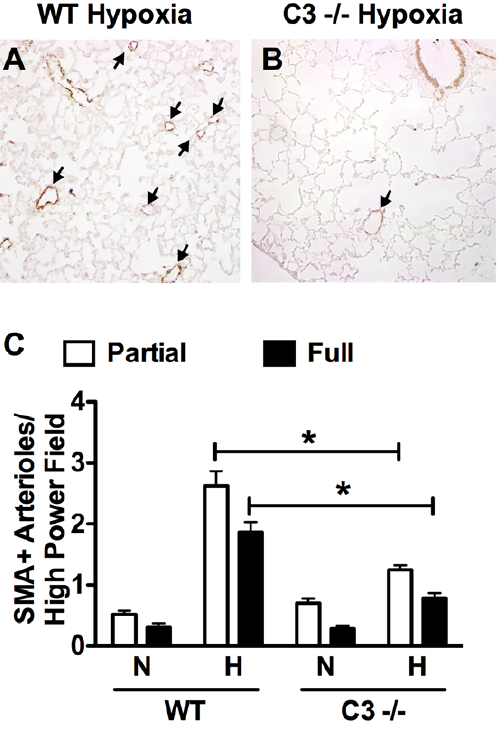
Figure 4. Loss of C3 attenuates muscularization of pulmonary arterioles in response to CH. (A–B) Representative photomicro- graphs of lungs stained against SMA from (A) hypoxic WT and (B) C3 2 / 2 mice. Arrows indicate muscularized arterioles. (C) Quantification of the number of partially and fully muscularized arterioles ( , 100 m m) per high power field (200 6 total magnification). Bars represent the mean 6 SD (n=4). * P , 0.05.